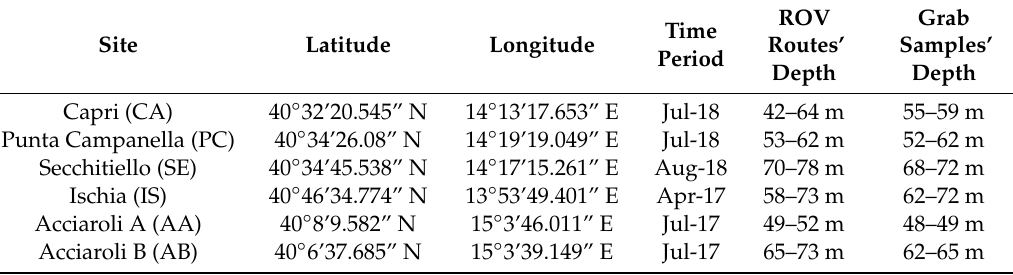
Figure 1. Map of the investigated sites along the Campania coast (Tyrrhenian Sea, Italy). Gulf of Naples’ sites: Capri (CA), Punta Campanella (PC), Secchitiello (SE), and Ischia (IS). Cilento coast’ sites: Acciaroli A (AA) and B (AB). Table 1. Resuming data of sampling sites.